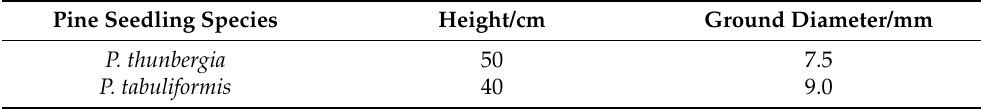
Table 1. Species, height and ground diameter of pine seedlings. Pine Seedling Species